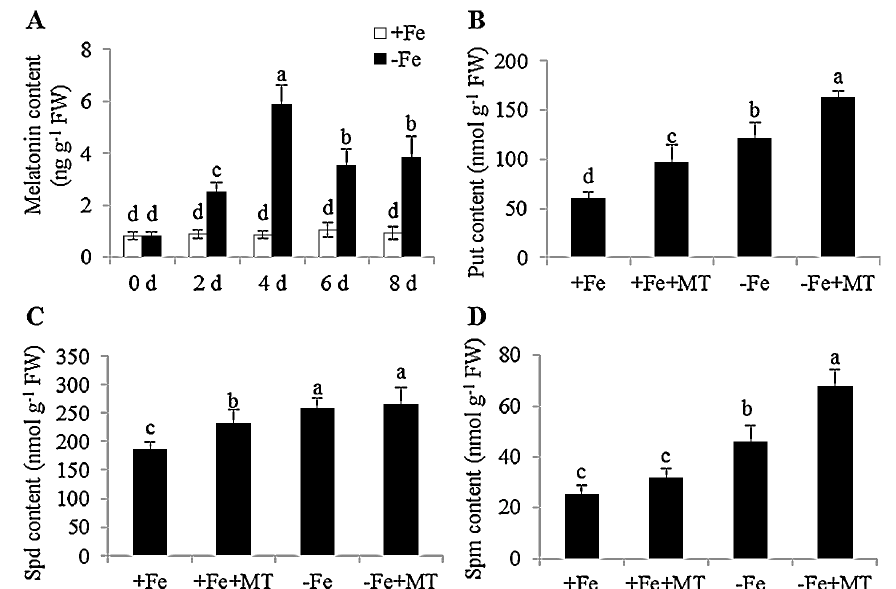
Figure 1. Changes of endogenous melatonin and polyamine content in response to Fe deficiency, and the effects of exogenous melatonin on cellular polyamine levels in Arabidopsis plants. Seven-day-old seedlings were placed in 1/2 MS liquid medium with or without the presence of 50 μ M Fe for the indicated time, then these plants were taken to measure melatonin content ( A ). In addition, seve-day-old seedlings were treated with or without 5 µ M melatonin under − Fe and +Fe conditions for 8 days. These plants were then used to determine cellular polyamine, including Put ( B ), Spd ( C ), and Spm ( D ). Each bar is the mean ± SE of at least three replicates, and different lowercase letters above the bars indicating significant differences using a Tukey’s test at p < 0.05.